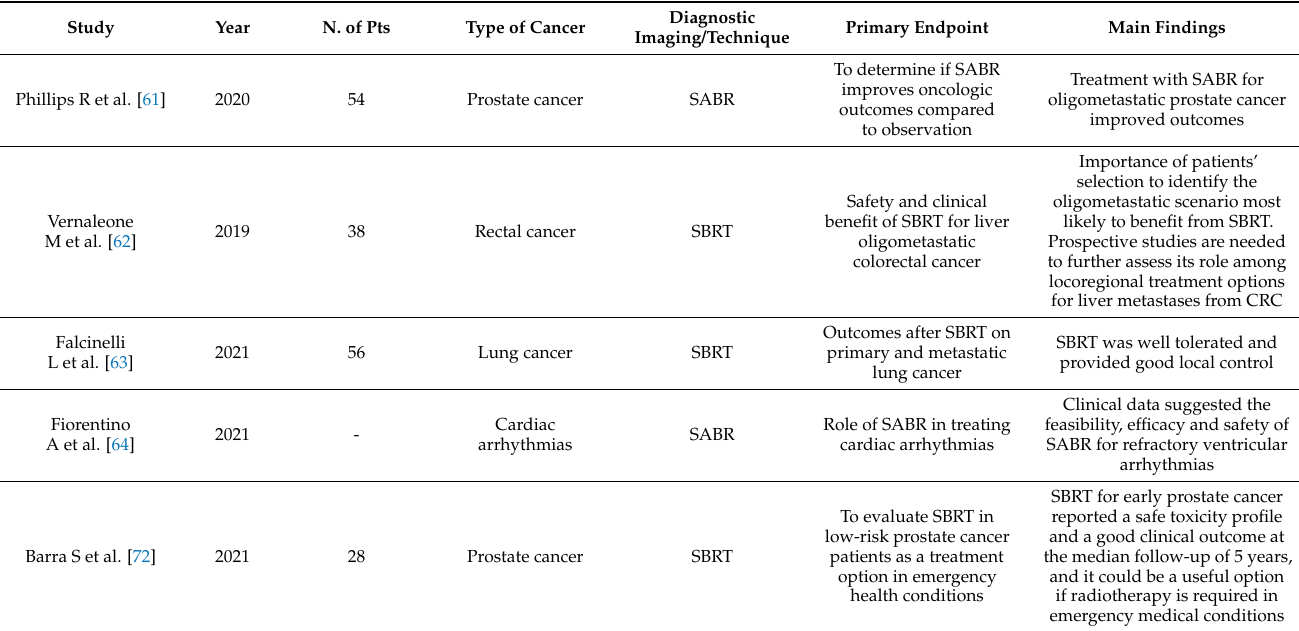
Table 7. Influence on systemic treatment and different medical